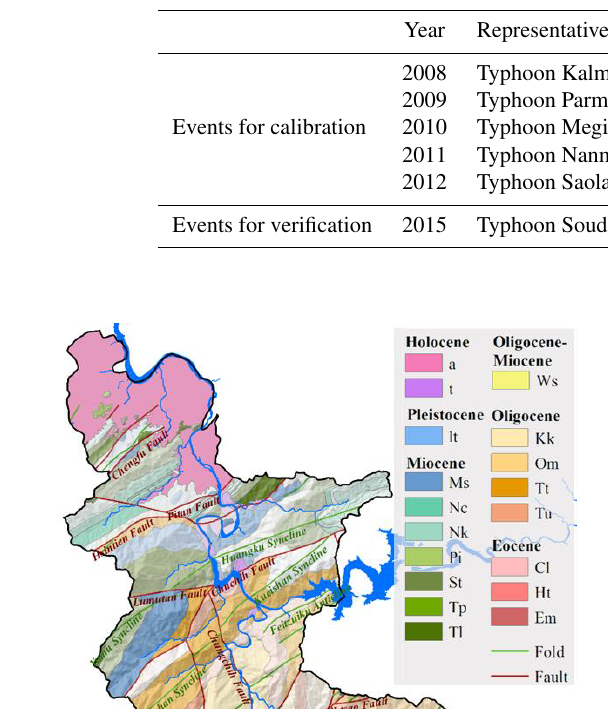
Table 2. Calibration and verification of the TRIGRS model based on MSR calculation.